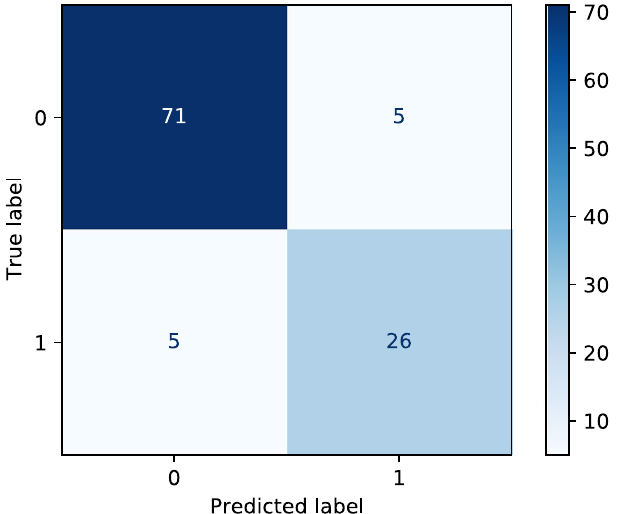
Figure 8. Confusion matrix obtained with the best model on the test set (0 : non-ICU patients and 1: ICU